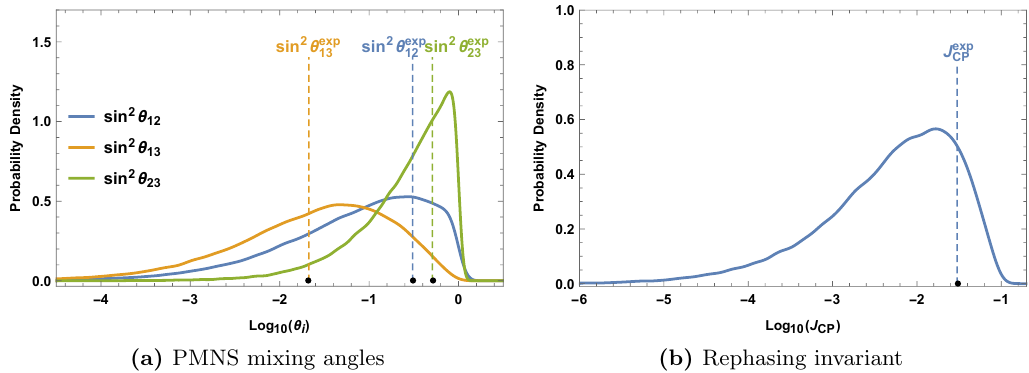
Figure 8. Lepton mixing distributions for N ‘ = 2, N e = 5, (cid:24) ‘ = 1 and (cid:24) e = 4.